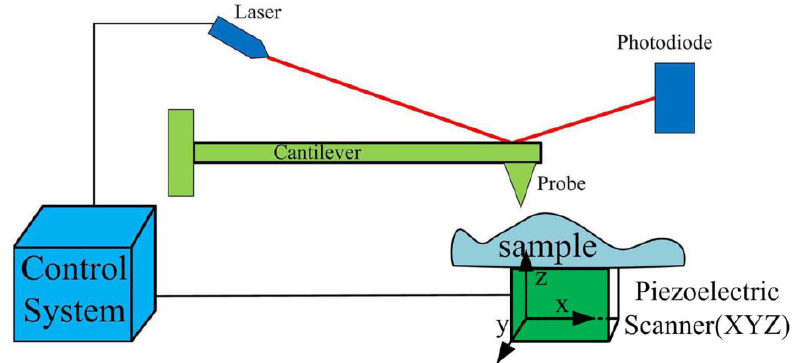
Figure 1. A schematic diagram of an atomic force microscope (AFM).